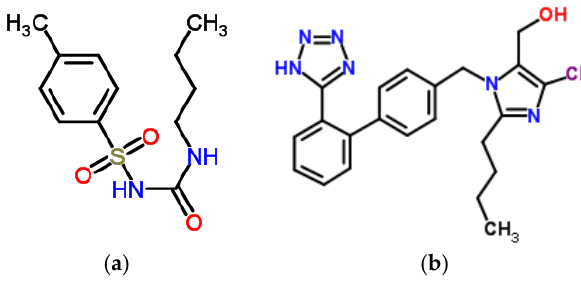
Figure 2. Chemical structure of ( a ) tolbutamide (TB) and ( b ) losartan (LOS).